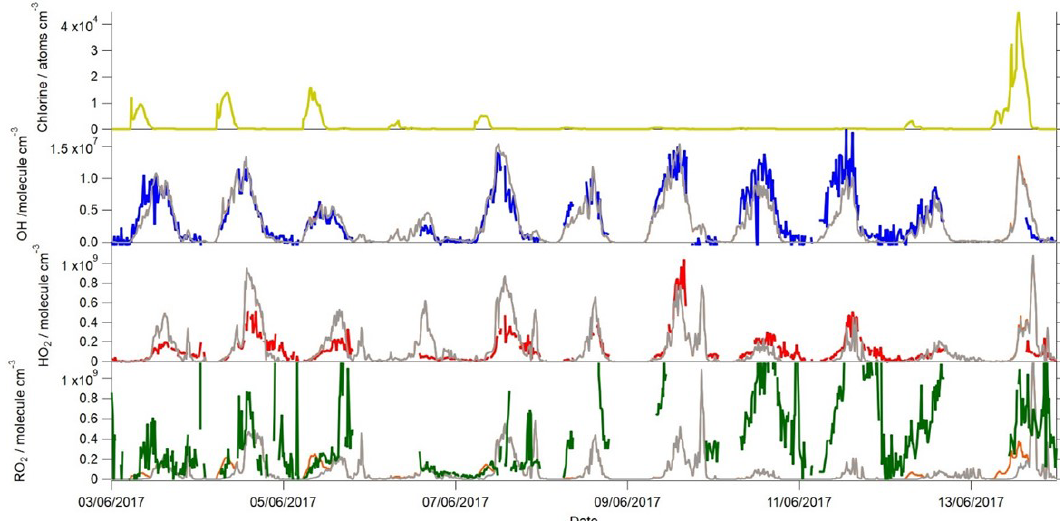
Figure 7. Time series of the measured and modelled OH, HO 2 and total RO 2 during the campaign when ClNO 2 was also measured. The Cl atom concentration calculated to be present is shown in the top panel. The measured OH concentrations are represented by the blue line, HO 2 by the red line and total RO 2 by the green line. The base model scenario is shown in grey, whilst the base model with Cl atom chemistry included (Xue et al., 2015) is shown in orange (only evident in the RO 2 panel).